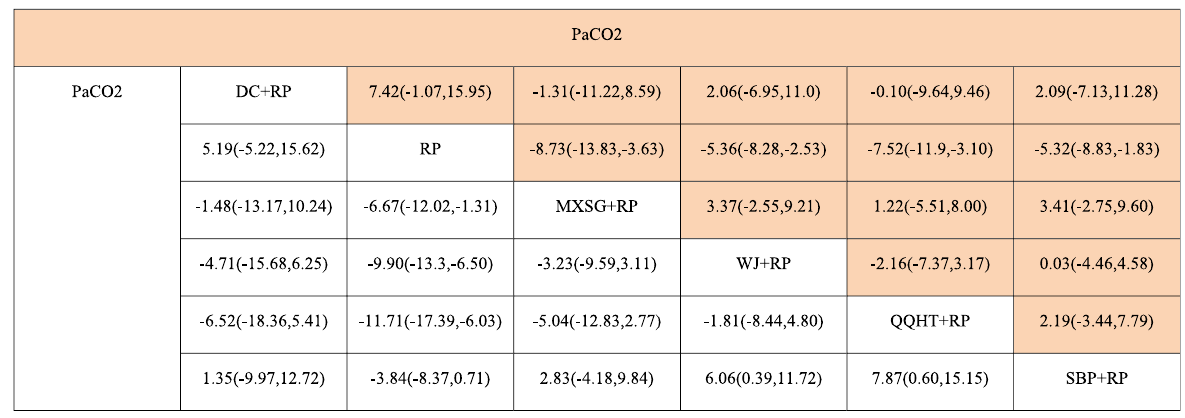
Table 4 Network meta-analysis of PaO2 and